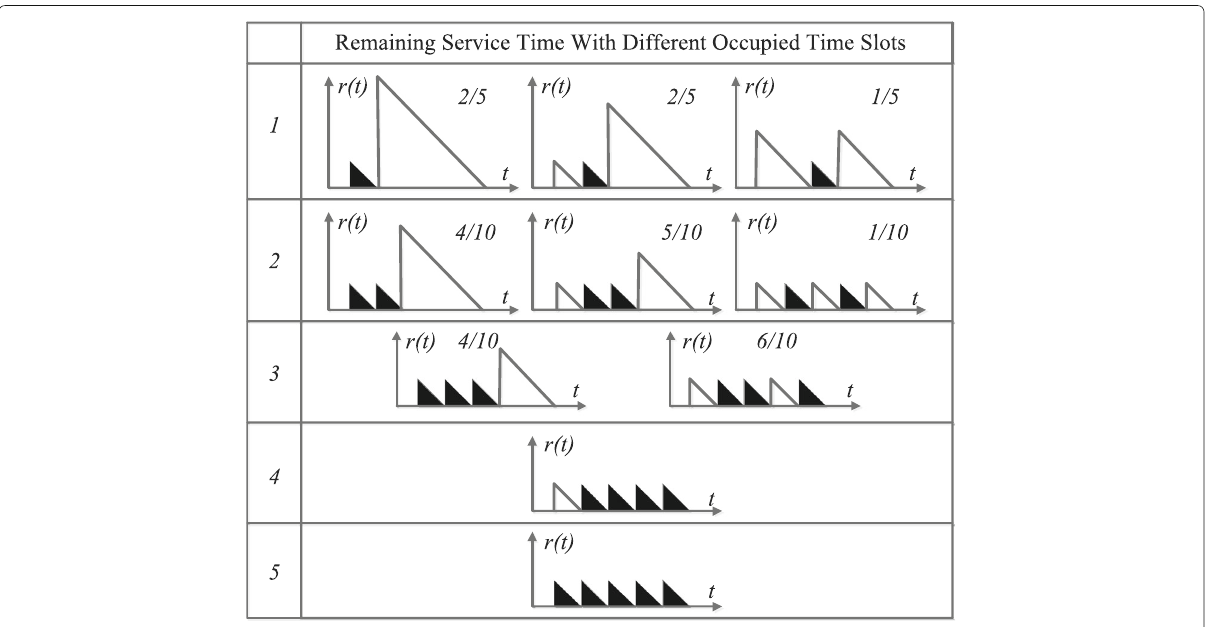
Fig. 8 Remaining service time with different occupied time